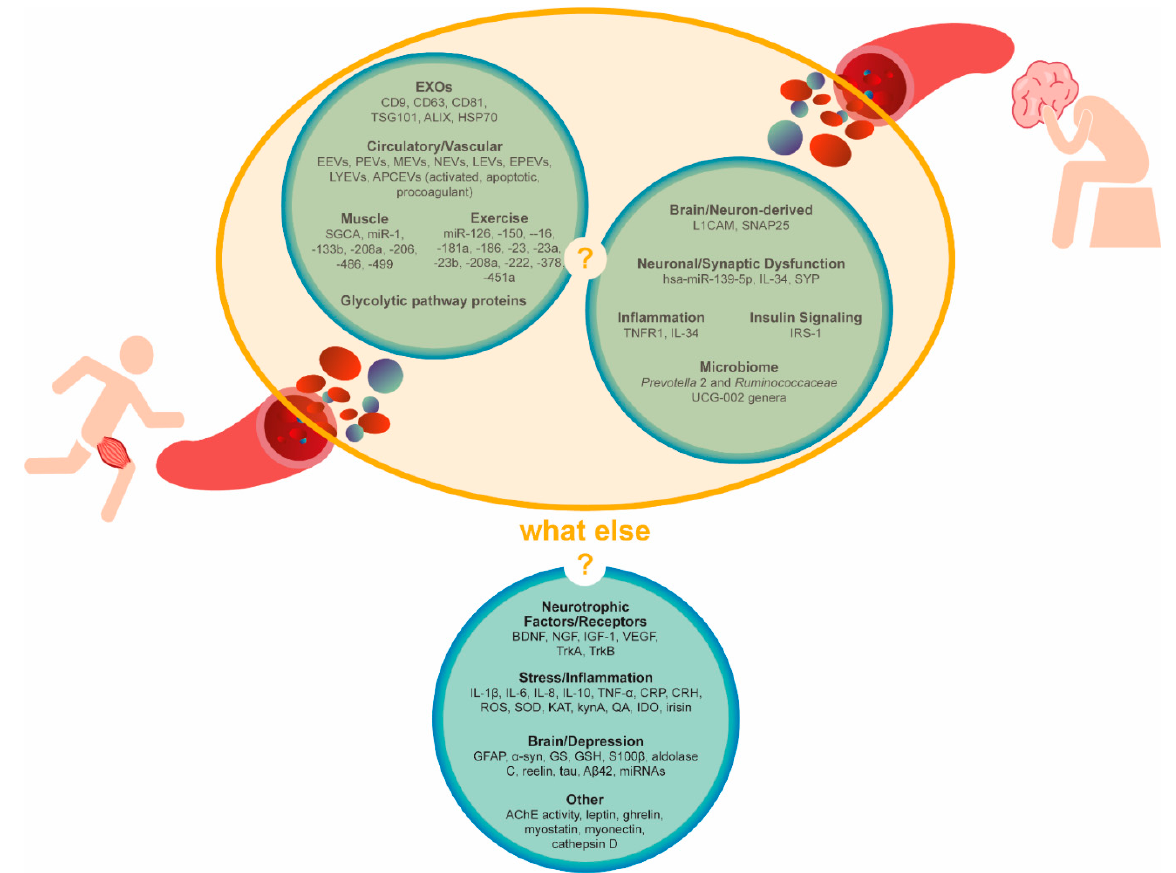
Figure 3. Circulating extracellular vesicle signatures after aerobic physical exercise or in the context of depression. Are they connected? Other candidate biomarkers. Circulating candidate biomarkers were suggested by the literature on physical exercise, inflammation or depression as either EV-cargoes or cell-free. AChE, acetylcholinesterase, APCEVs, antigen-presenting cell-derived vesicles, A β 42, amyloid β 42 BDNF, brain-derived neurotrophic factor, CRH, corticotropin-releasing hormone, CRP, C reactive protein, EEVs, endothelial-derived vesicles, EPEVs, endothelial progenitor cell-derived vesicles, EVs, extracellular vesicles, EXOs, exosomes, GFAP, glial fibrillary acidic protein, GS, glutamine synthetase, GSH, glutathione, HSP70, heat-shock protein 70, IDO, indoleamine 2,3-dioxygenase, IGF-1, insulin-like growth factor 1, IL, interleukin, IRS-1, insulin receptor substrate, KAT, kynurenine aminotransferase, kynA, kynurenic acid, LEVs, leucocyte-derived vesicles, LYEVs, lymphocyte-derived vesicles, L1CAM, L1 cell adhesion molecules, MEVs, monocyte-derived vesicles, NEVs, neutrophil-derived vesicles, NGF, nerve growth factor, PEVs, platelet-derived vesicles, QA, quinolinic acid, ROS, reactive oxygen species, S100 β , S100 calcium-binding protein β , SNAP25, synaptosomal nerve-associated protein 25, SOD, superoxide dismutase, SYP, synaptophysin, TNF- α , tumor necrosis factor α , TrkA, tropomyosin receptor kinase A, TrkB, tropomyosin receptor kinase B, TSG101, tumor susceptibility 101, VEGF, vascular endothelial growth factor and α - syn, α -synuclein.